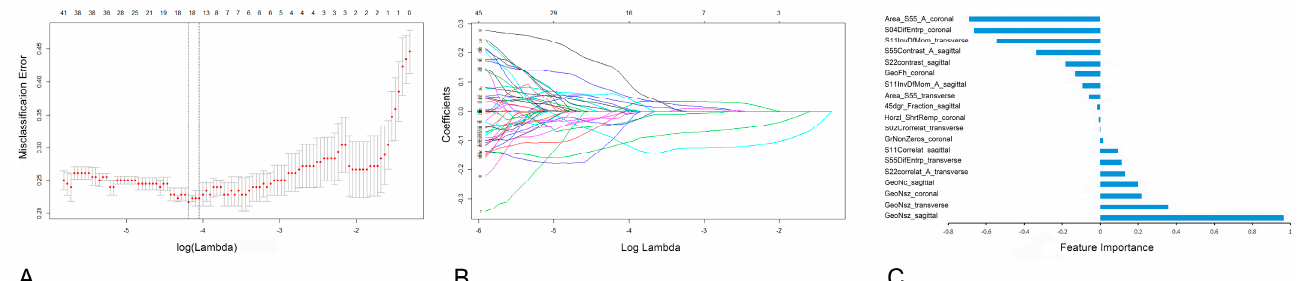
Figure 2. A total of 19 key radiomic features were identified by least absolute shrinkage and selection operator regression (LASSO). ( A ) Repeat 50 times of 10-fold cross-validation process to identification the optimal penalization coefficient lambda ( λ ) in the LASSO model, and 19 nonzero coefficients were obtained according to the λ . The red dots represent the mean value of the target parameters. ( B ) LASSO coefficient profiles were plotted against the log ( λ ) sequence. ( C ) Ranked the importance of 19 key features.